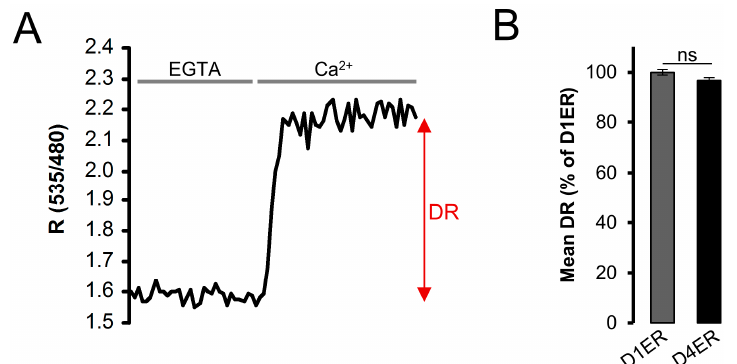
Figure 3. D1ER and D4ER dynamic range (DR) comparison. ( A ) BHK cells expressing D4ER were permeabilized with digitonin (20 µ M) for 30 seconds in an intracellular-like medium containing EGTA (600 µ M). Cells were then perfused with EGTA (600 µ M), to record minimal R values and then with CaCl 2 (3 mM), to get maximal values. A representative trace is presented as variations in ratio value between acceptor and donor fluorescence intensity (R); and ( B ) the histogram shows the DR, calculated as the ratio between R max and R min , for D1ER and D4ER probes. Data are presented as mean ± s.e.m. (normalized to D1ER dynamic range); N ≥ 51 cells for each condition; ns (not statistically significant) = p > 0.1, unpaired Student’s t test.